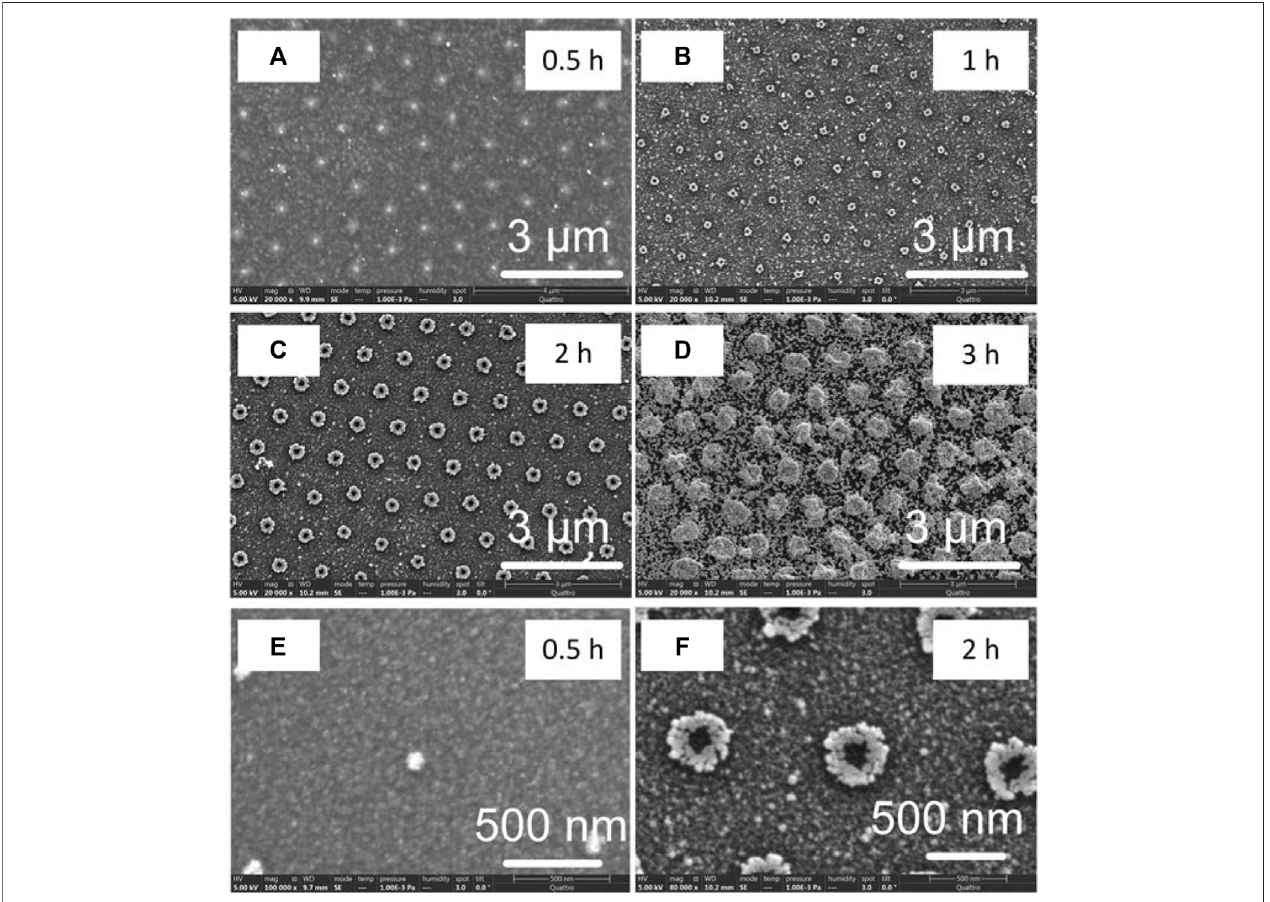
FIGURE 2 | (A) — (D) SEM images of periodic gold periodic nanostructures formed at the reduction times of 0.5 h, 1 h, 2 h and 3 h, respectively (E) and (F) High magni fi cation SEM images of (A) and (C) , respectively.